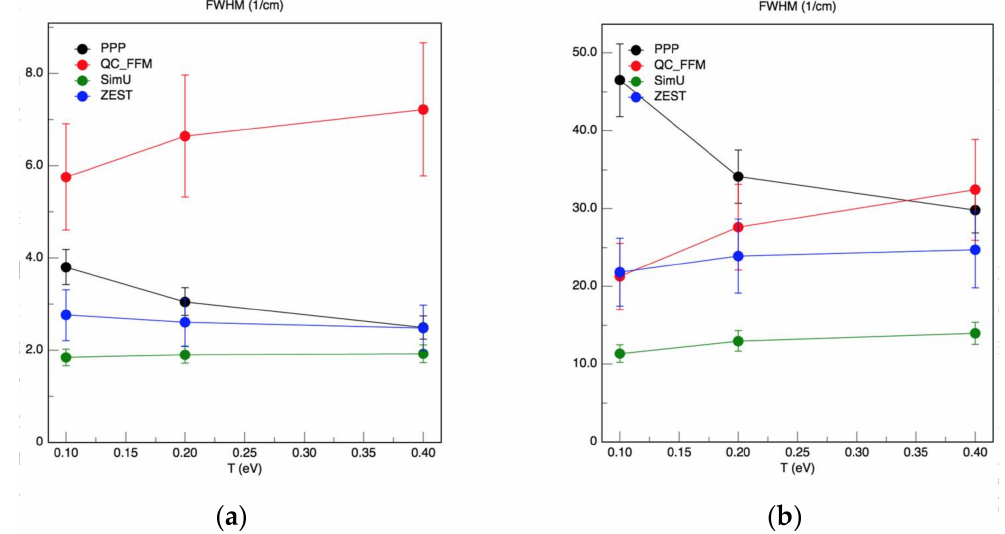
Figure 7. The He I line full width at half maximum (FWHM) versus the electron temperature as deduced from the profiles calculated by the four codes PPP, QC_FFM, SimU and ZEST. ( a ) Lowest density ( n e = 10 15 cm − 3 ). ( b ) Highest density ( n e = 10 16 cm − 3